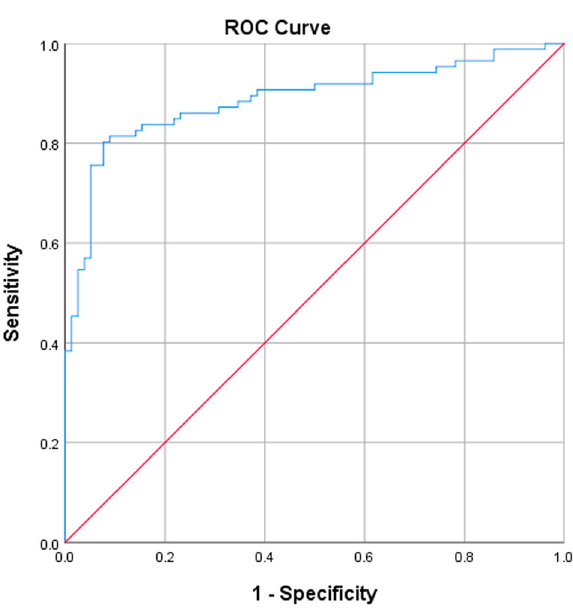
Fig. 3 Receiver operator curve. Acute exacerbation of COPD ( ≥ 65 years): AUC = 0.91 (95% CI: 0.85 –